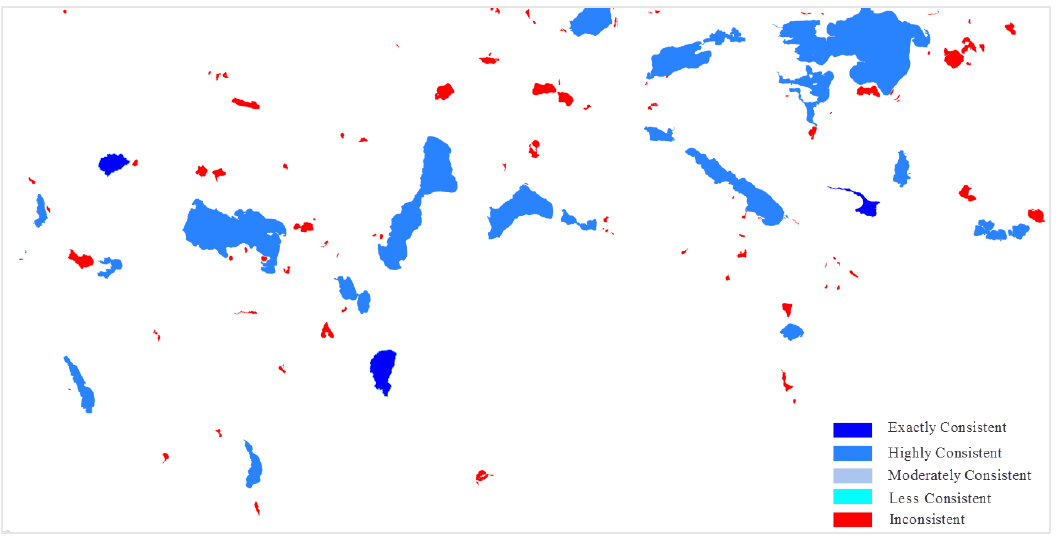
Figure 16. Detection results. Table 3. Detection results.